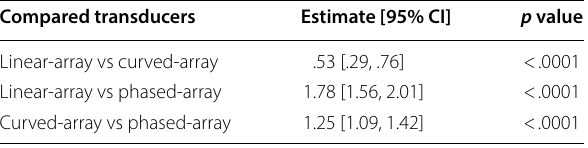
Table 5 Difference in image quality between transducer